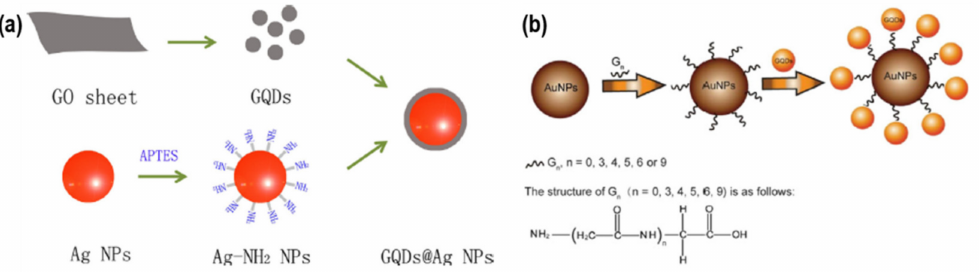
Figure 8. Ex situ preparation of GQD-inorganic nanocomposites. Schematic illustration of the synthesis of ( a ) Ag@GQDs core shell [89] and ( b ) AuNP/G n /GQDs nanocomposites